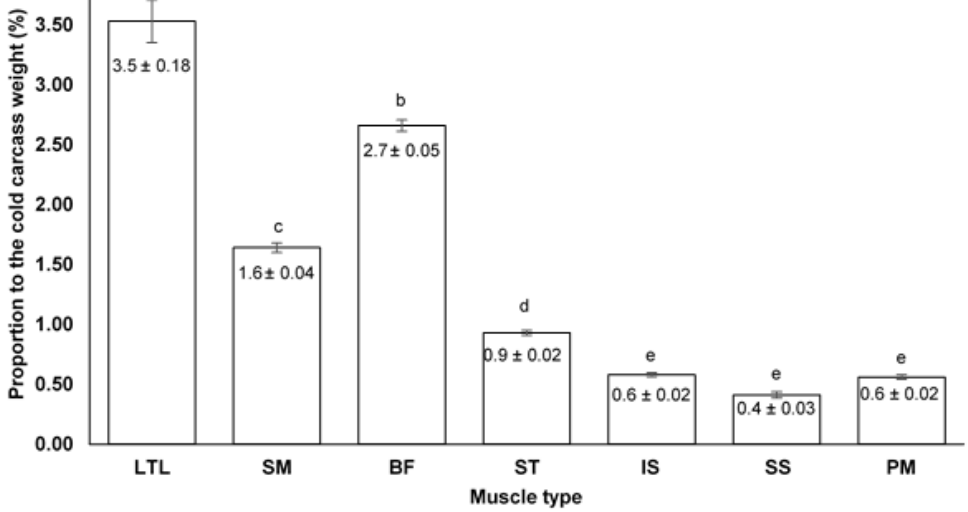
Figure 1. The percentage contribution (mean ± SE) of the longissimus thoracis et lumborum (LTL), semimembranosus (SM), biceps femoris (BF), semitendinosus (ST), infraspinatus (IS), supraspinatus (SS) and psoas major (PM) muscles to the average cold carcass weight of Plains zebra stallions harvested during two seasons in the Western Cape Province of South Africa. a–e Means with different letters differ ( p < 0.05).